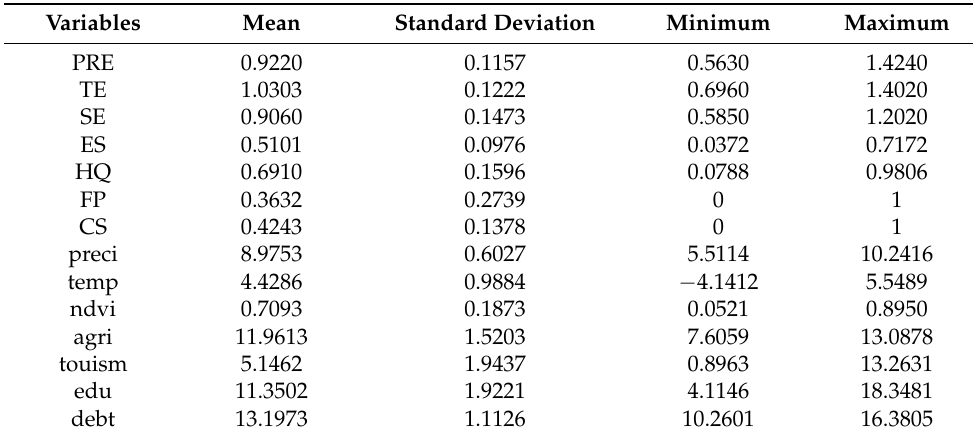
Table A2. Descriptive statistics of variables in the panel model.